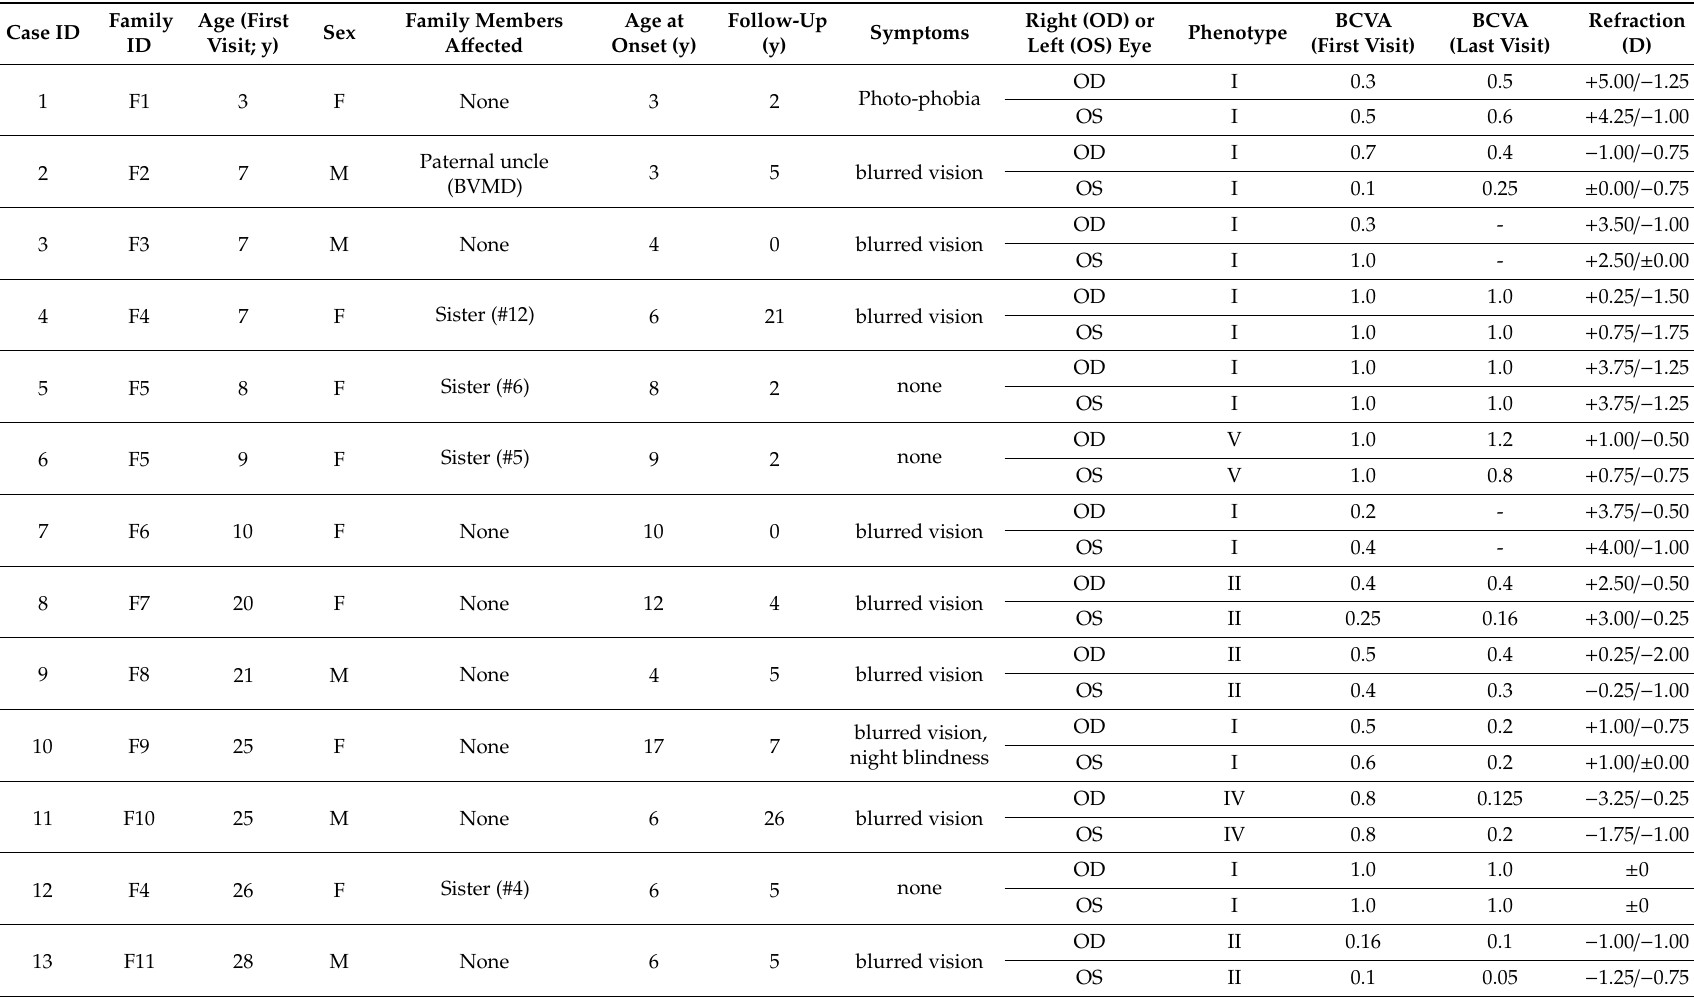
Table 1. Clinical